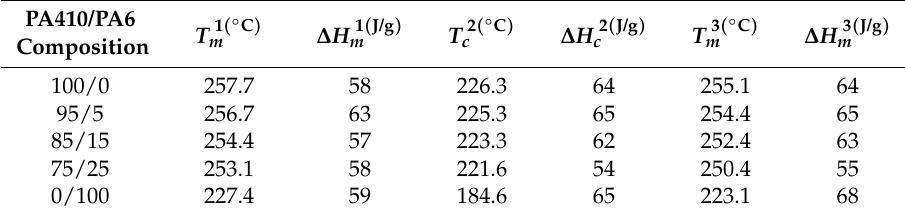
Table 2. Calorimetric parameters of PA410/PA6 blends.